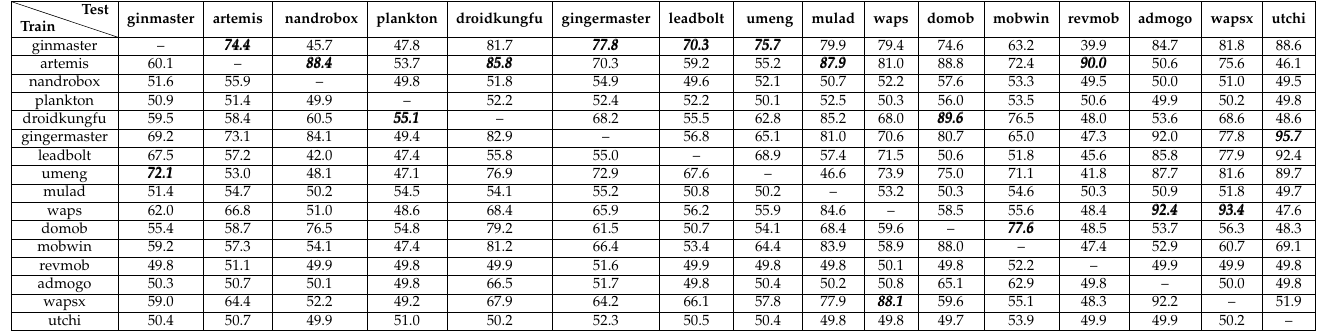
Table 5. Malware detection performance with different malware families in the training set using mamadroid. The number in bolds show the best results.